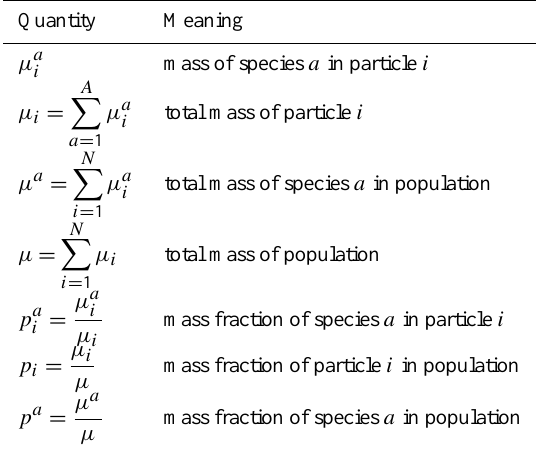
Table 1. Aerosol mass and mass fraction definitions and notations. The number of particles in the population is N , and the number of species is A .